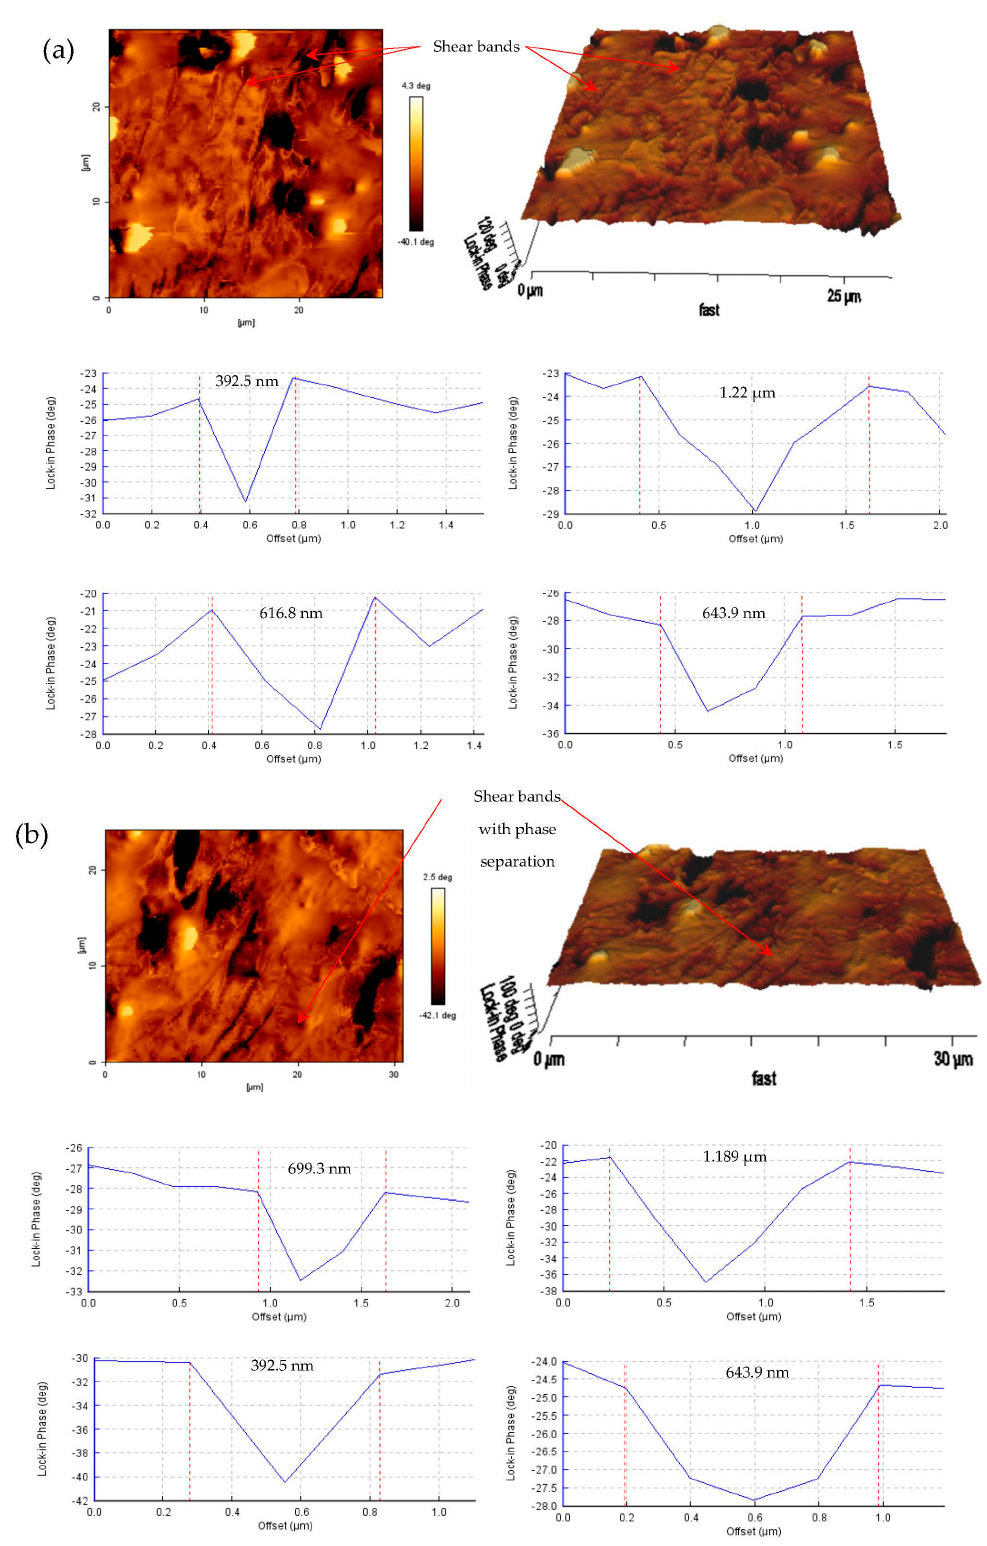
Figure 7. AFM taping-mode images of two- and three-dimensional in-phase topography of the shear band deformation zone. ( a ) Shear bands; ( b ) shear bands with a thicker phase separation.